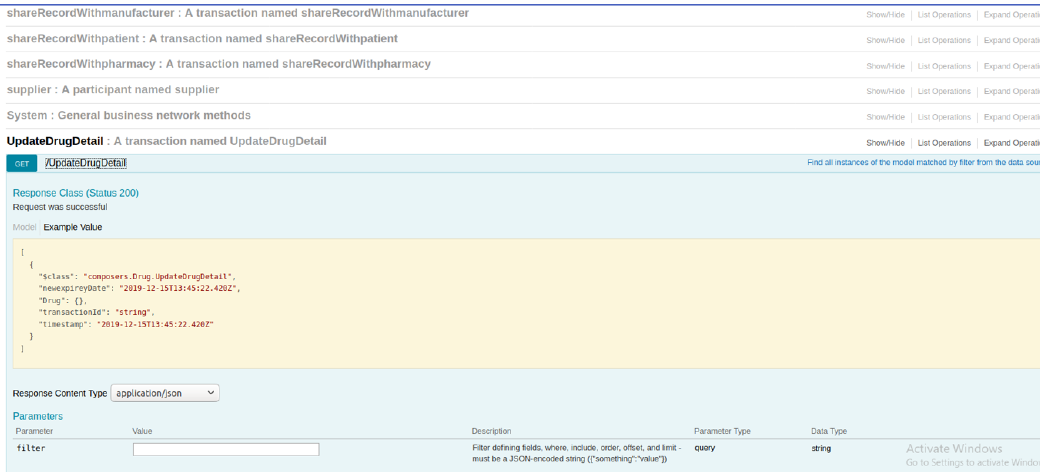
Figure 15. Rest server user interface and communication using